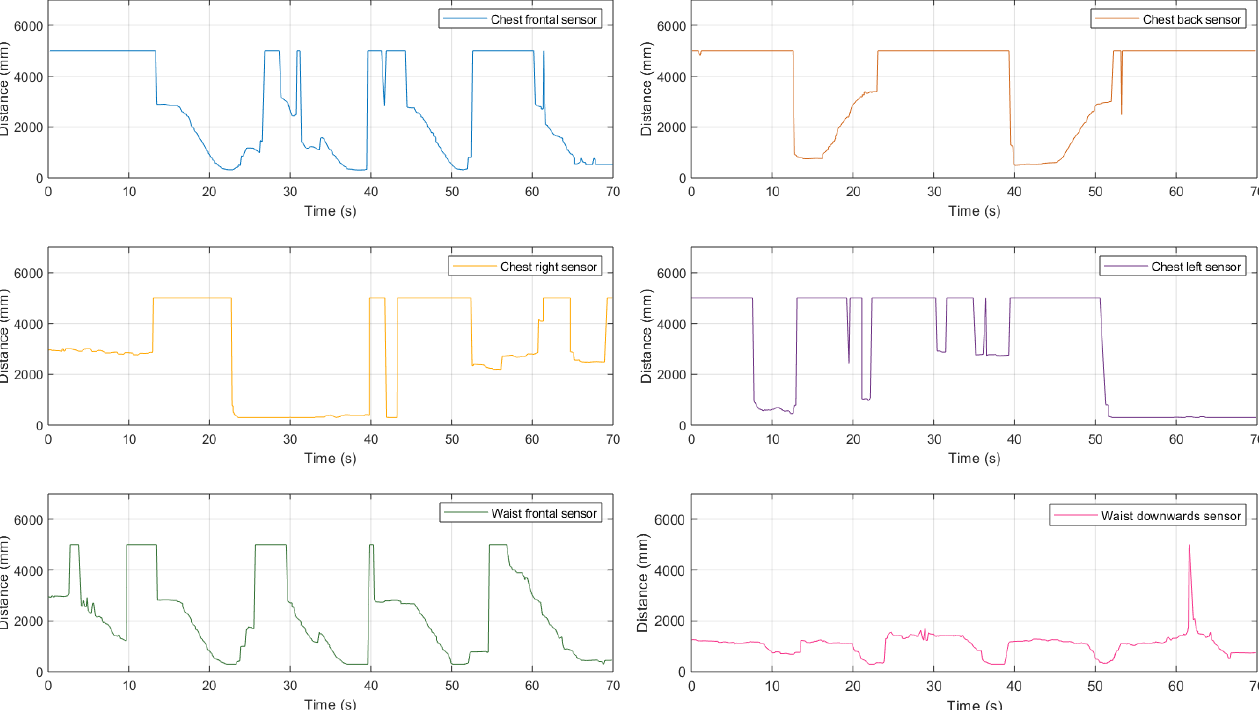
Figure 24. Distance estimates detected with the configuration shown in Figure 17, during a mixed path followed in the house